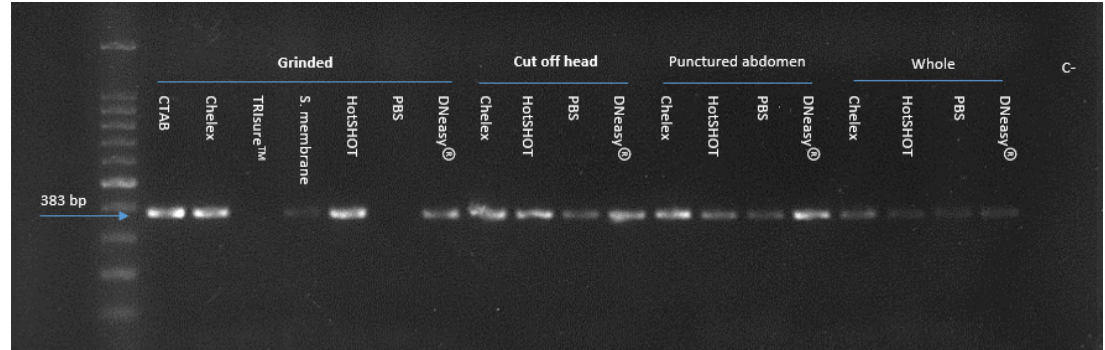
Figure 4. Agarose gel electrophoresis of products by Lso TX 16/23 primers, showing the 383 bp CaLsol-specific DNA fragment (arrow), obtained for seven DNA extraction methods and four specimen preparations. C-: negative control (right line). A 100 bp DNA ladder was included (left line).